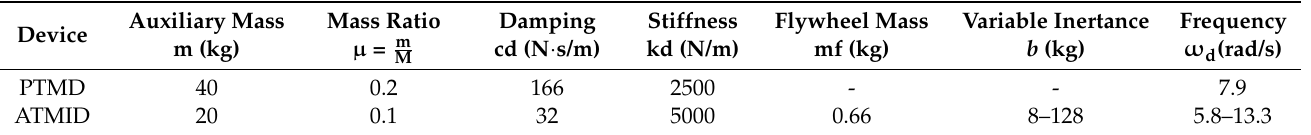
Table 2. Device parameters for TMD and proposed